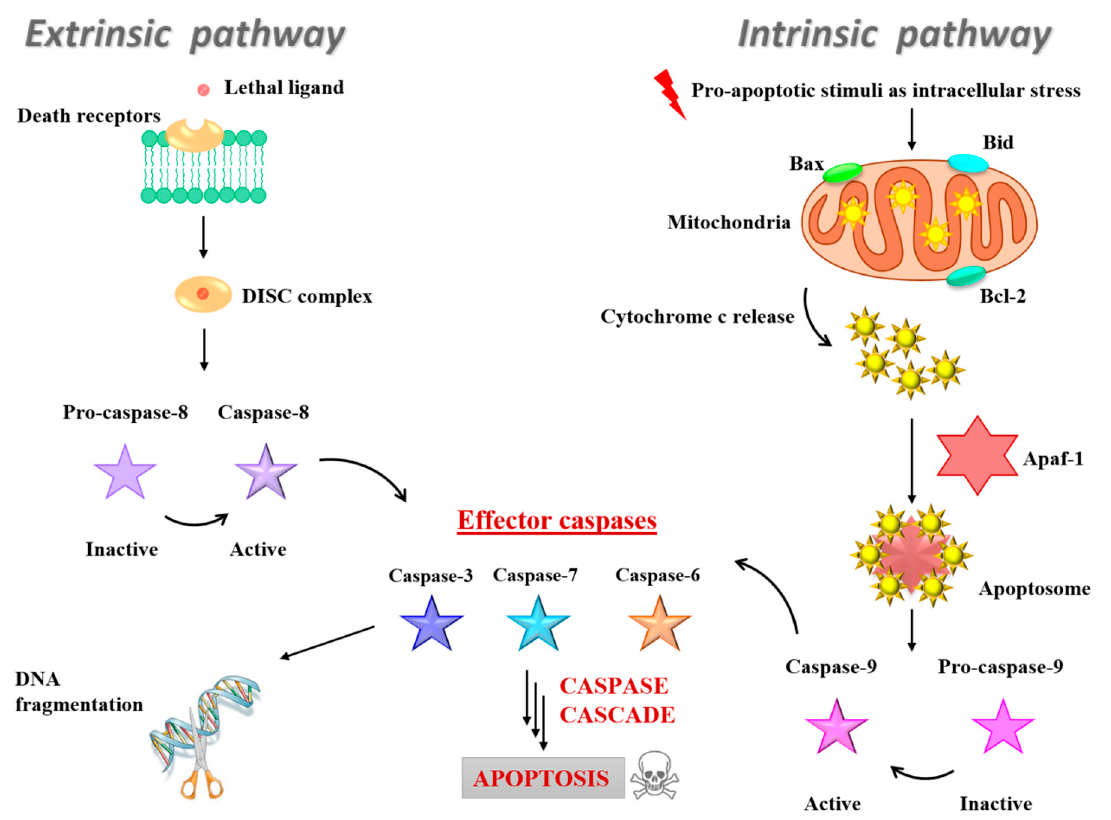
Figure 12. Schematic representation of the intrinsic (or mitochondrial) and the extrinsic (or death receptor) apoptotic pathways.